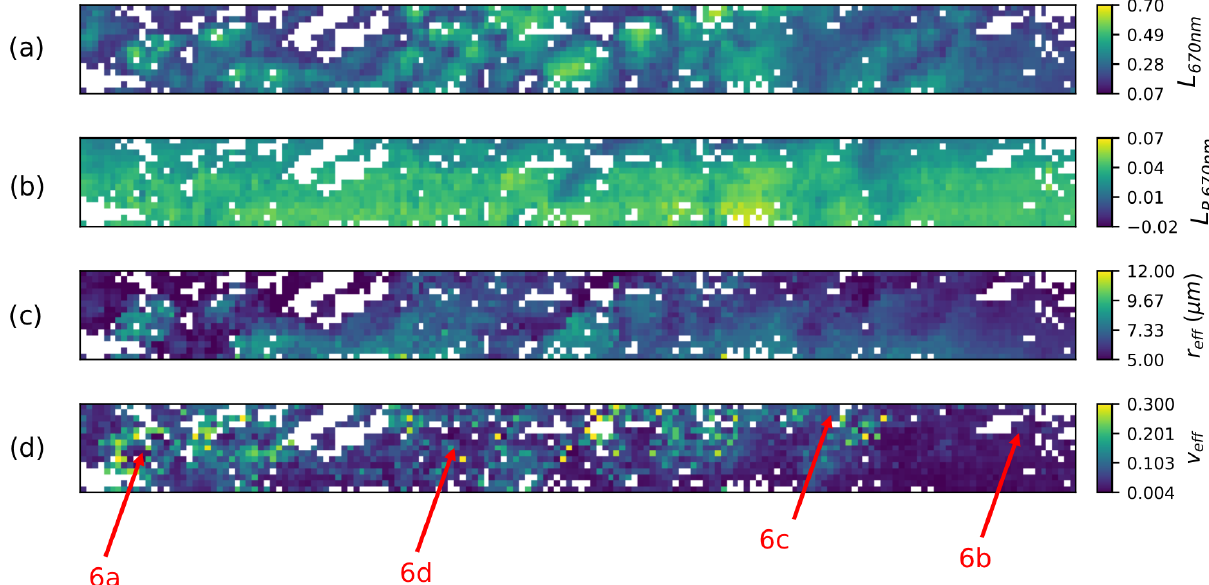
Figure 7. Nadir push-broom images for 670nm of total intensity (a) and polarized intensity (b) , as well as for the retrieved CDR (c) and CDV (d) for 200m (4 × 4) gridded superpixels with access to 135–165 ◦ in scattering angle using hyper-angular co-located data. Quality- flagged retrievals are screened out (white). Note that the polarized reflectance is smoother compared with the reflectance image, and both represent nadir ( − 0 . 003 ◦ ) view sector push brooms. The general locations of each retrieval from Fig. 6 are identified in red. The scene stretches 3km cross-track and 34km